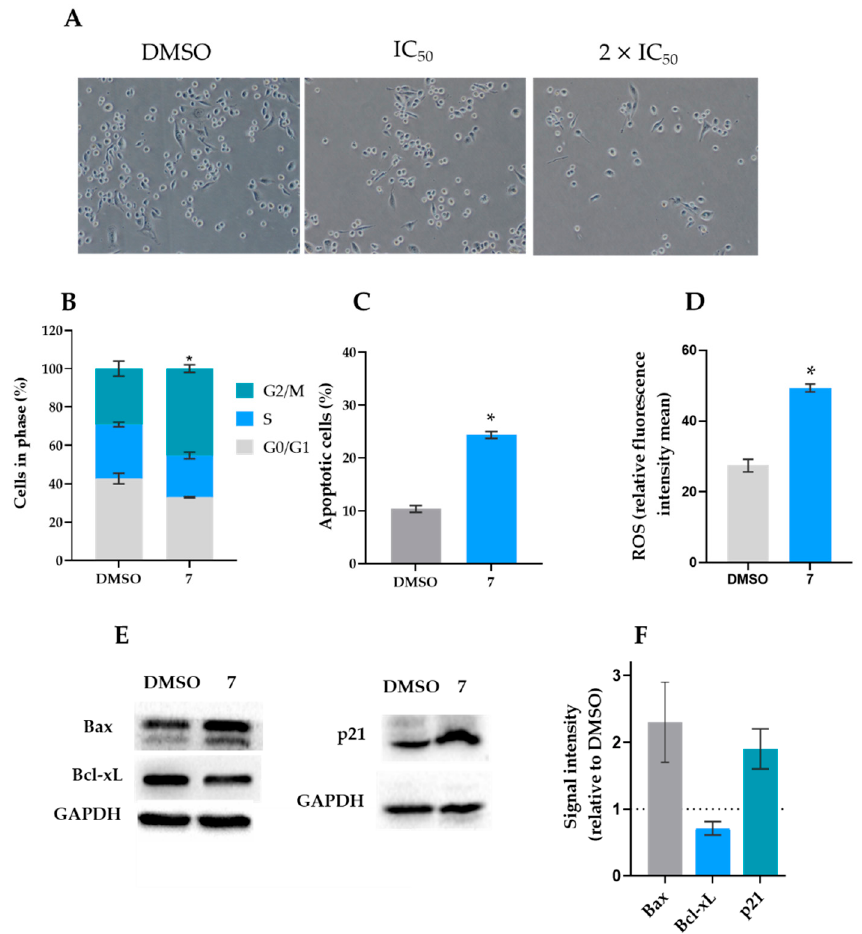
Figure 2. Compound 7 induced cell cycle arrest, apoptosis, and ROS production, in MDA-MB-231 cells. ( A ) Effect of 8 (IC 50 ) and 16 (2 × IC 50 ) µM of compound 7 on MDA-MB-231 cell cytotoxicity after 48 h of treatment. ( B ) Effect of 16 µM of compound 7 on cell cycle progression after 48 h of treatment in MDA-MB-231 cells; the percentage of cells in each phase of the cell cycle was analyzed by flow cytometry, using PI; data are mean ± SEM of three independent experiments. Values are significantly different from DMSO (* p < 0.05, unpaired Student’s t -test). ( C ) Effect of 16 µM of compound 7 on apoptosis after 48 h of treatment; the percentage of Annexin-positive cells was analyzed by flow cytometry using PI and Annexin-V staining; data are mean ± SEM of three independent experiments. Values are significantly different from DMSO (* p < 0.05, unpaired Student’s t -test). ( D ) Effect of 16 µM of compound 7 on mitochondrial ROS generation after 24 h of treatment; data are mean ± SEM of three independent experiments (* p < 0.05, unpaired Student’s t -test). ( E ) Effect of 16 µM of compound 7 after 48 h of treatment on the protein expression levels in MDA-MB-231 cells. Immunoblots are representative of three independent experiments. GAPDH was used as a loading control. ( F ) The graph represents the quantification of protein expression levels relative to DMSO; data are mean ± SD of three independent experiments. The ability of compound 7 to induce apoptosis in this cell line was also assessed by cytometry, using the Annexin V-FITC assay after 48 h of treatment. Apoptosis is characterized by distinct morphologic features. In the early stages of apoptosis, the membrane phospholipid phosphatidylserine is translocated from the inner to the outer plasma membrane leaflet. Annexin V is a phospholipid-binding protein with a high affinity to phosphatidylserine, which is able to detect apoptotic cells with the externalization of phosphatidylserine [32]. The results showed a significant increase in the percentage of apoptotic cells in MDA-MB-231 cells compared to the vehicle control after treatment with 16 µM of compound 7 (Figure 2C). In line with this, it was further observed that 16 µM of compound 7 increased ROS production in MDA-MB-231 cells (Figure 2D).